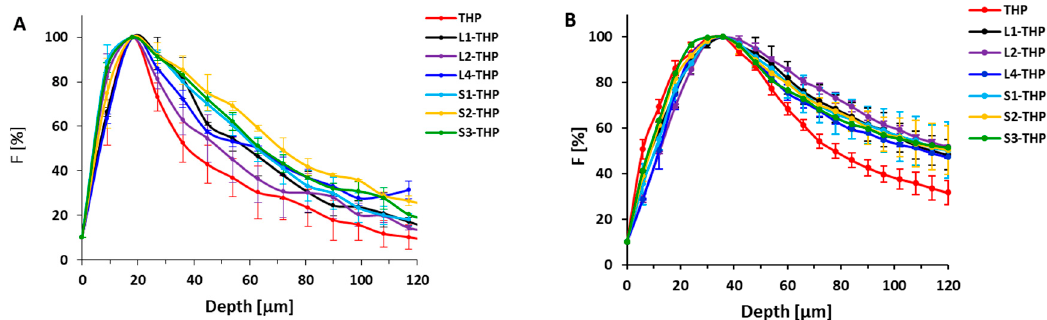
Figure 4. ( A ) Fluorescence profiles of THP and THP-polymer conjugates in C26 tumor spheroids after 6 h incubation and ( B ) fluorescence profiles of free THP and THP-polymer conjugates in U87-MG tumor spheroids after 6 h. The fluorescence intensity dependence on the distance from the surface of the tumor spheroid was analyzed from several spheroids ( > 3). The percentage of fluorescence distribution is normalized to the maximum mean fluorescence intensity of the THP near the surface (100%) and outside the spheroid (0%).